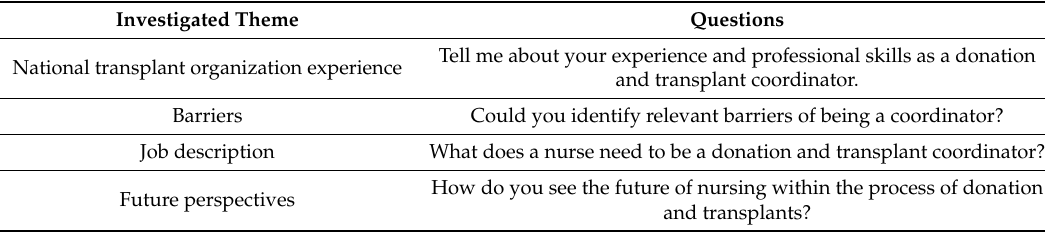
Table 1. Semistructured interview